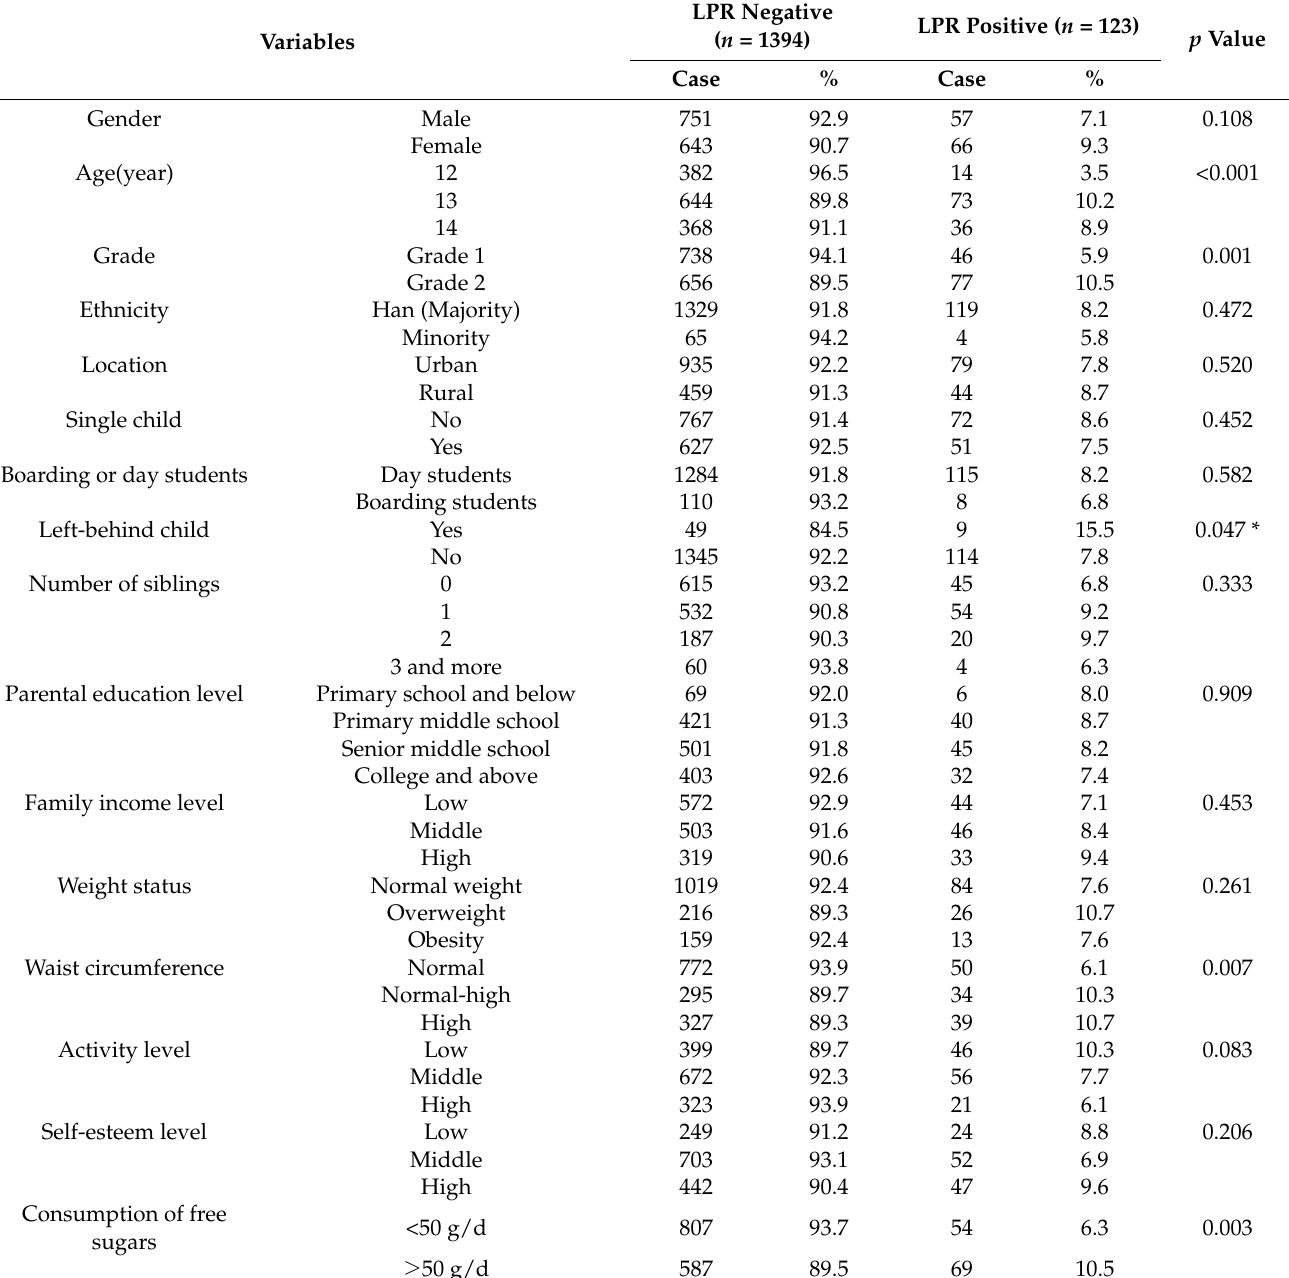
Table 2. Characteristics and laryngopharyngeal reflux condition of participants ( n =